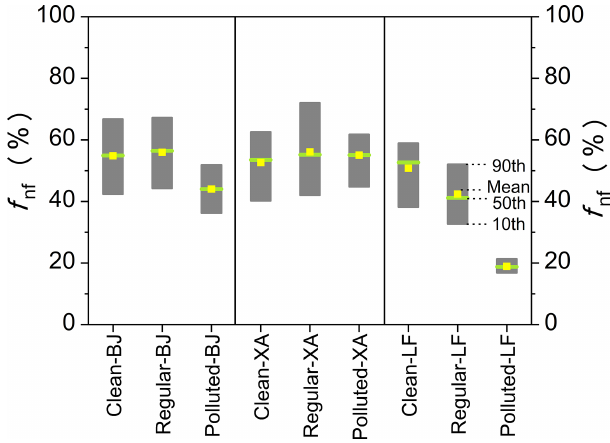
Figure 4. Box plot distribution of f nf of samples with differ- ent pollution levels. Clean samples: PM 2 . 5 < 75µgm − 3 ; regu- lar samples: 75µgm − 3 ≤ PM 2 . 5 < 150µgm − 3 ; polluted samples: PM 2 . 5 ≥ 150µgm − 3